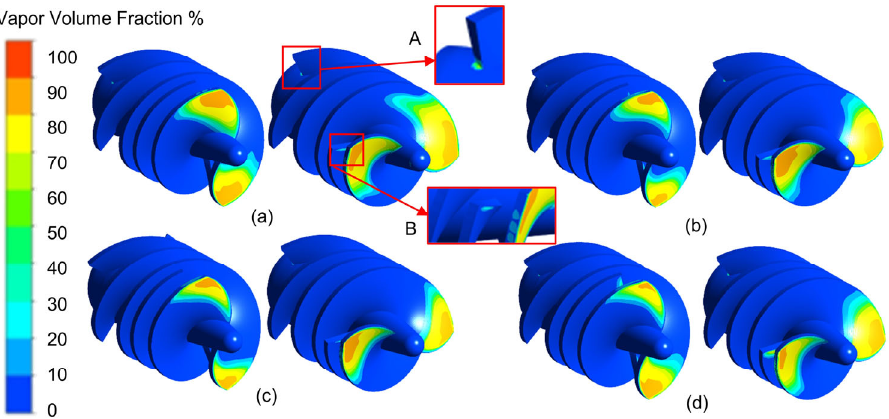
Figure 13. Cavitation distribution of inducer under different TCs: ( a ) TC= 0.2 mm, ( b ) TC= 0.3 mm, ( c ) TC= 0.4 mm and ( d ) TC= 0.5 mm.